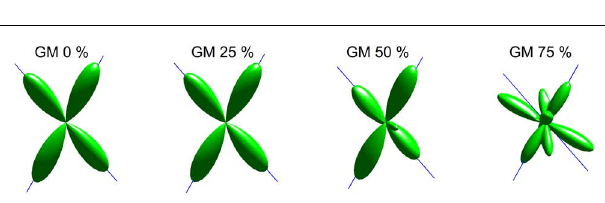
FIGURE 2 |An illustration of fODFs estimated with CSD with GM partial volume increasing from 0 to 75% (with up to eighth-order SH, diffusion weighting 3000 s/mm 2 , angle 70 ◦ , and SNR 30). The blue lines correspond to the correct fiber